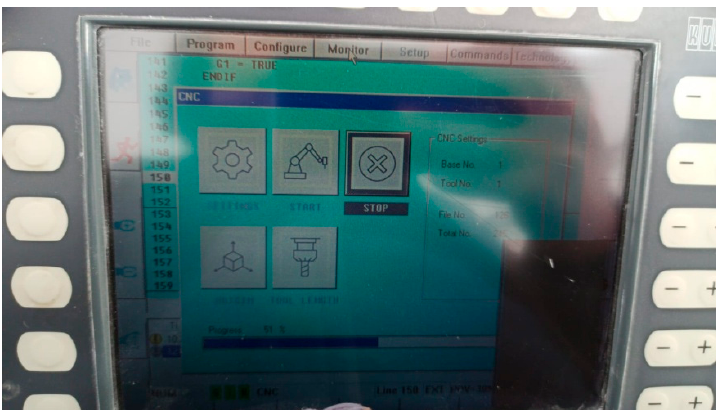
Figure 9. TCP Socket Server software screenshot on Kuka Control Robot Unit (VKRC2).